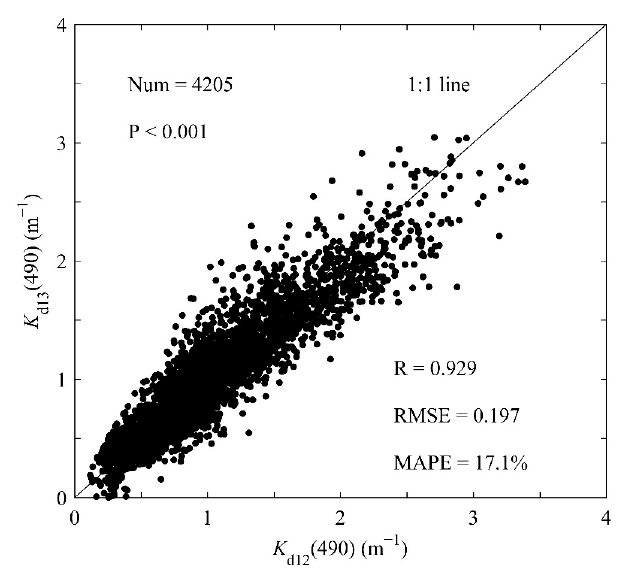
Figure 4. Linear correlations between buoy-measured K d12 ( 490 ) and K d13 ( 490 ) (redrawn from Zhang et al.